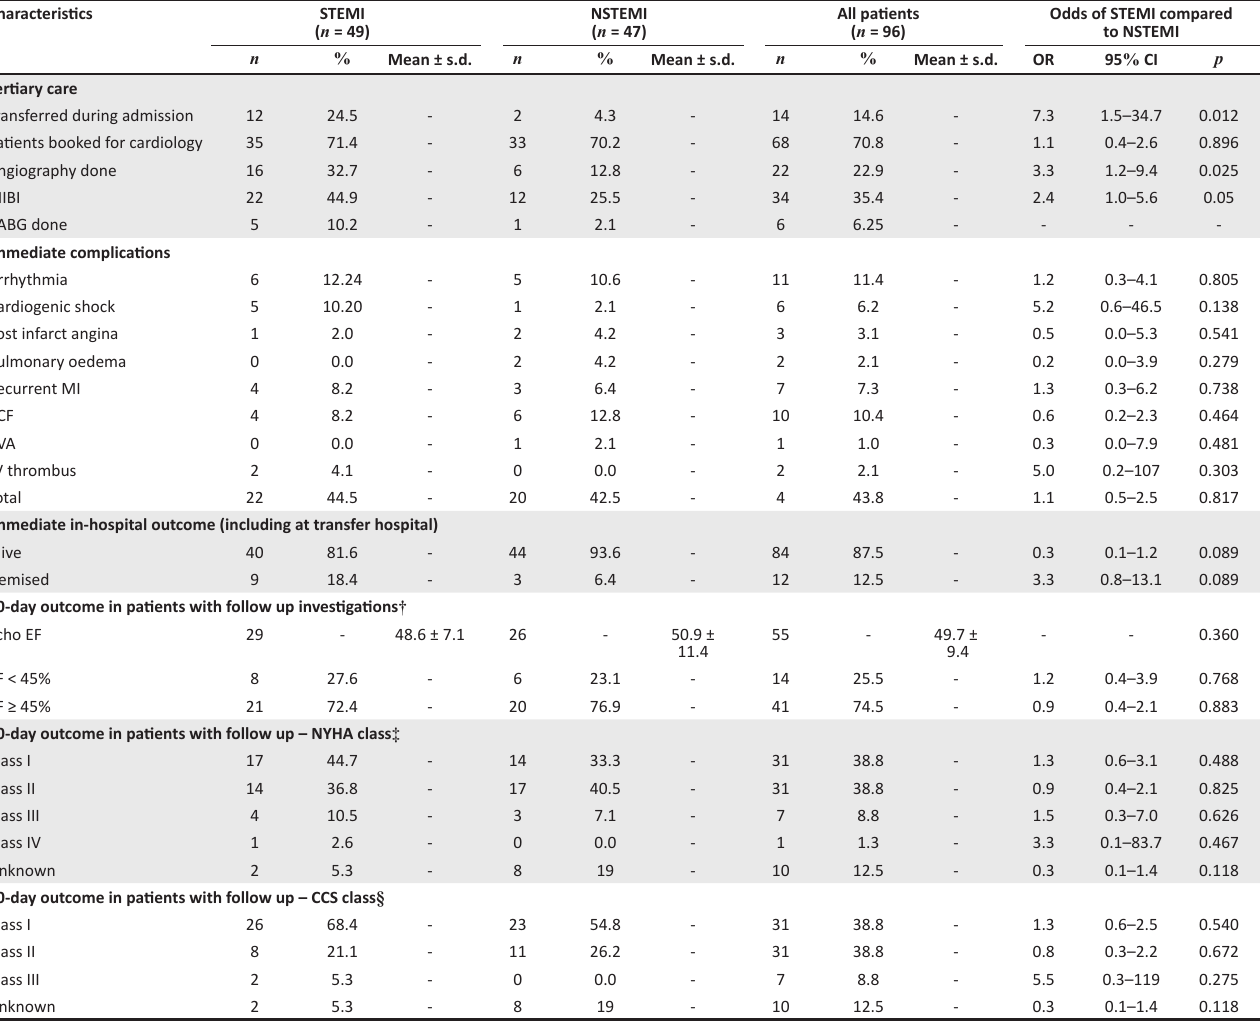
TABLE 3: Tertiary involvement and outcomes of patients with acute myocardial infarction.